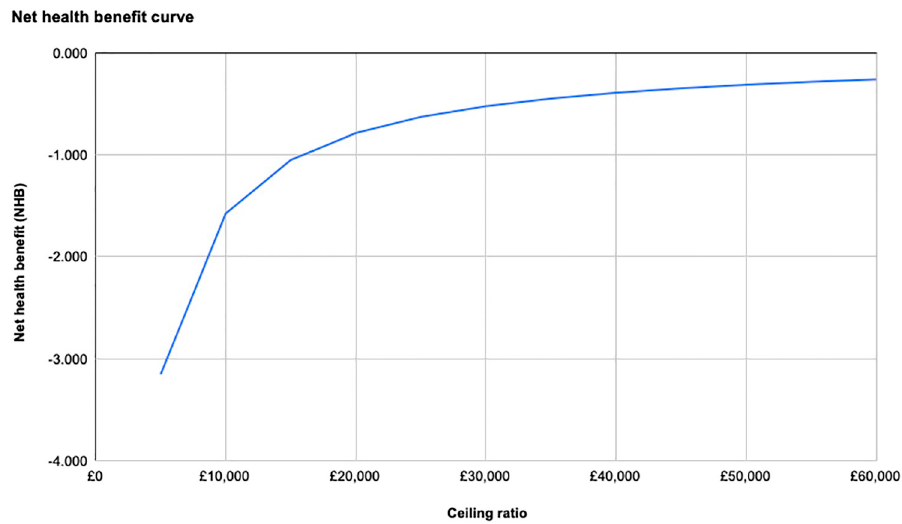
Fig 4. NHB curve of RARC compared to the ceiling ratio.